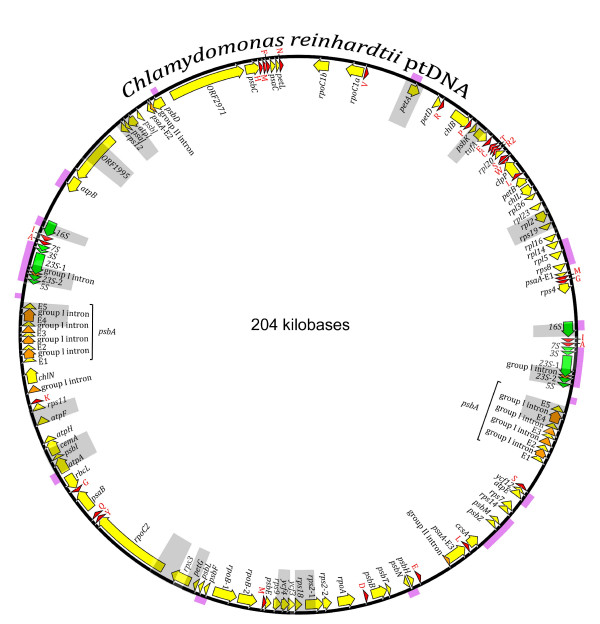
Genetic map of the Chlamydomonas reinhardtii plastid genome. Protein-coding regions are yellow and their exons are labeled with an "E" followed by a number denoting their position within the gene. Introns and their associated open reading frames are orange. Transfer RNA-coding regions are red and are represented by the single-letter code of the amino acid they specify. Ribosomal RNA-coding regions are green. All of the coding regions are shaped into arrows that denote their transcriptional polarities. Gray blocks correspond to the loci that were sequenced and used for measuring nucleotide diversity. The portions of the C. reinhardtii strain CC-2290 plastid genome that were data mined from GenBank are highlighted in pink.